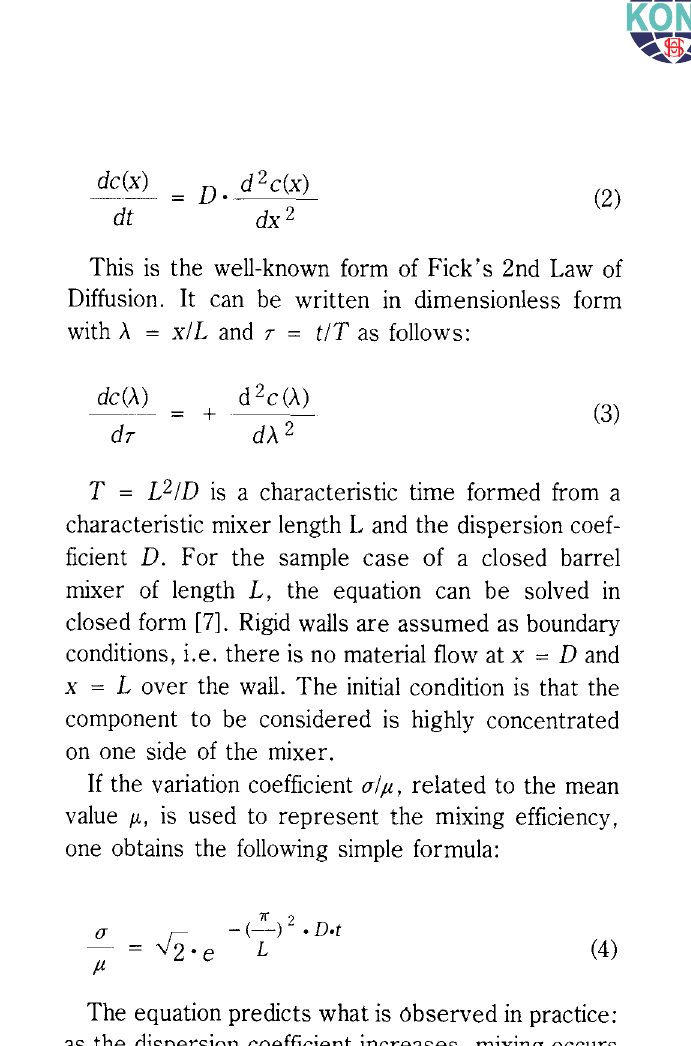
Fig. 1 Demixing tendency caused by convective flow in a batch mixer [7]